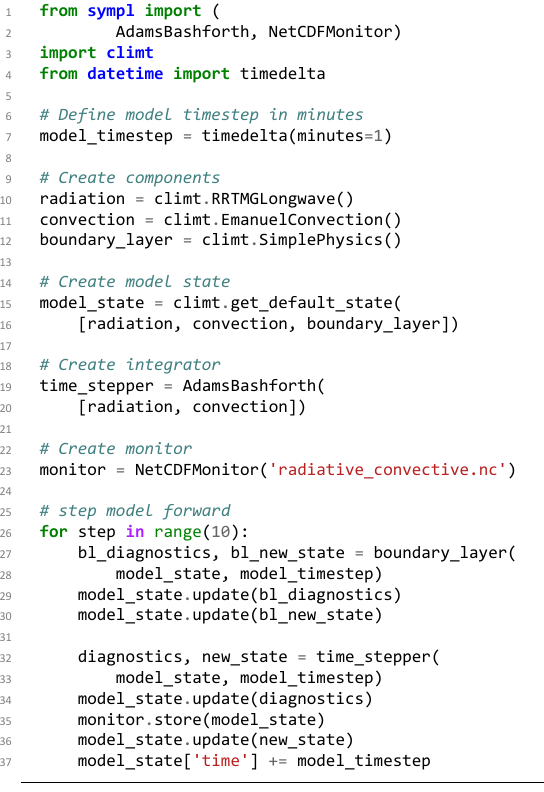
Fig. 2, creating a moist atmospheric general circulation model (AGCM) in an aqua-planet configuration with a pre- scribed sea surface temperature. The default surface temper- ature is horizontally uniform, but we omit prescribing a re- alistic temperature distribution for purposes of